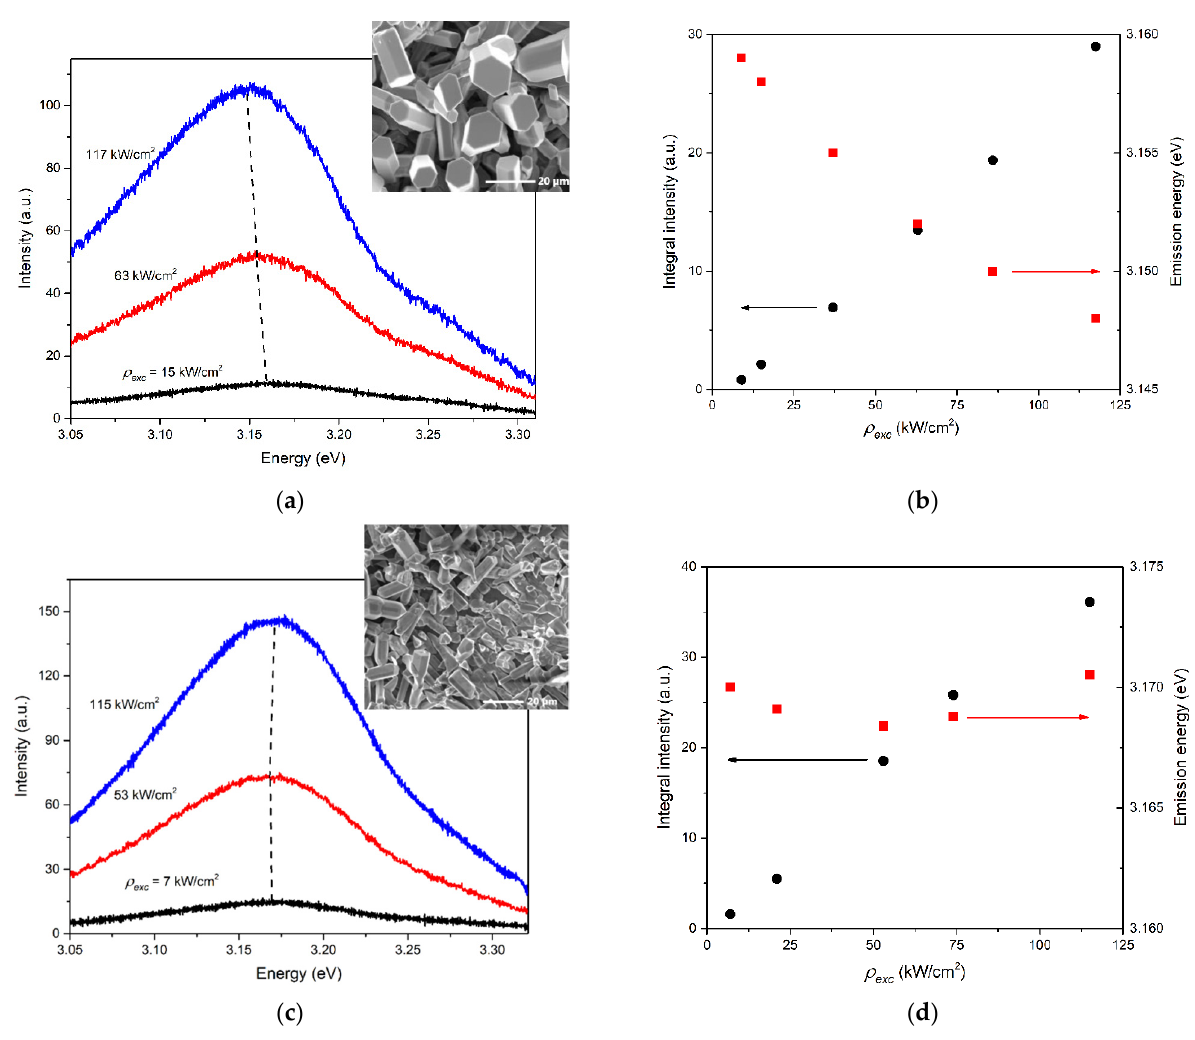
Figure 3. RT ASE of the sample: ( a , c ) type I ( a ) and type II ( c ) emission spectra at different 𝜌 (cid:3032)(cid:3051)(cid:3030) ; ( b , d ) integral intensity (black circles) and emission energy at maximum intensity (red squares) vs. 𝜌 (cid:3032)(cid:3051)(cid:3030) for the type I ( b ) and type II ( d ) emission spectra. The insets in ( a , c ) show the sample’s regions with well ( a ) and weakly ( c ) faceted microcrystals.